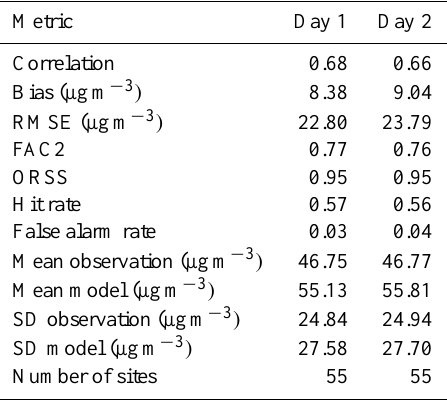
Table 7. AQUM performance metrics for ozone forecasts over the period 1 May 2010 to 30 April 2011, illustrating variation with fore- cast lead time. The small differences in the means and standard de- viations of the observations used for evaluating forecasts are due to minor variations in data availability over the